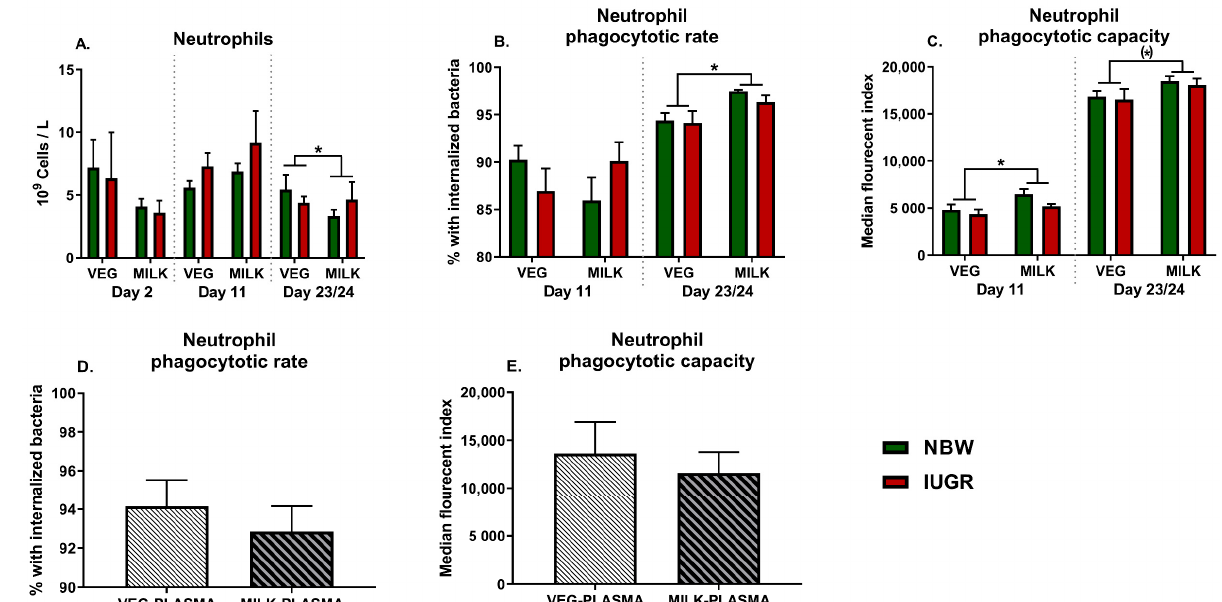
Figure 1. Development of neutrophil counts and function in animals fed either vegetable (VEG, n = 11–18) or milk fat (MILK, n = 11–18) further stratified into normal birthweight (NBW, n = 12–18) or intrauterine growth restricted (IUGR, n = 10–18) animals. ( A ) Neutrophil counts, ( B ) Neutrophil phagocytic rate, ( C ) Neutrophil phagocytic capacity, ( D ) Neutrophil phagocytic rate of farm raised 19-day-old piglets where plasma has been substituted with pooled plasma samples from either vegetable (VEG-PLASMA, n = 7) or milk-fed animals (MILK-PLASMA, n = 7). ( E ) Neutrophil phagocytic function in either VEG-PLASMA or MILK-PLASMA. All results presented as means with corresponding standard errors. *: p < 0.05, (*): p < 0.1.